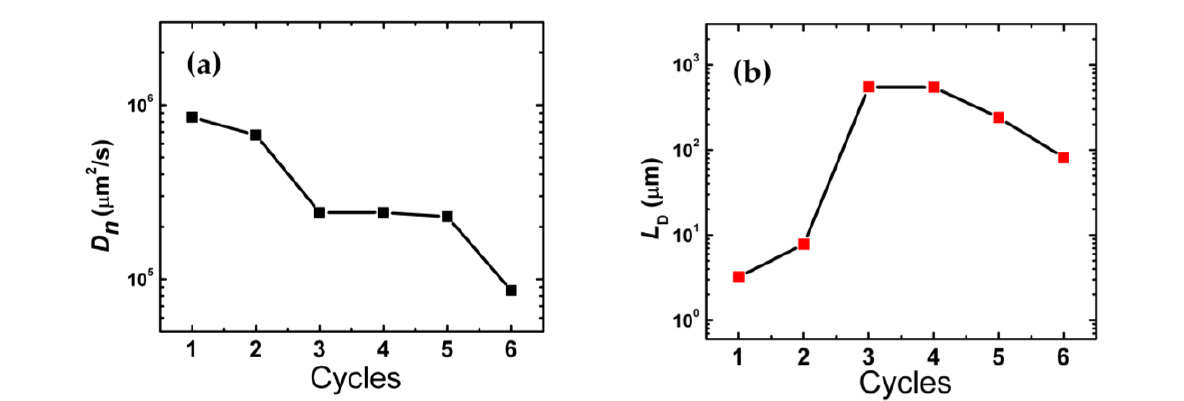
Figure 4. ( a ) Intensity modulated photocurrent spectroscopy (IMPS) Nyquist plot for ZnO:TiO 2 nanowire photoanode coated with CdSe quantum dots (QDs) by increasing SILAR deposition cycles under 1 sun illumination. ( b ) Transport time constants, τ trs, calculated from the IMPS data for 1 to 6 SILAR cycles.